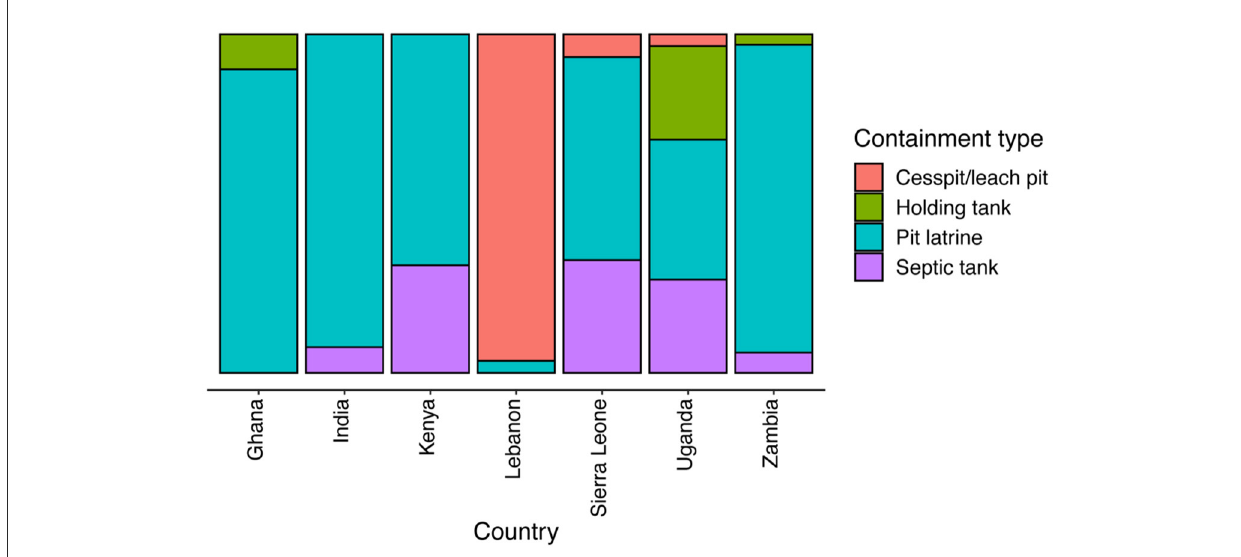
FIGURE4 Distribution of the different containment types sampled by each partner.